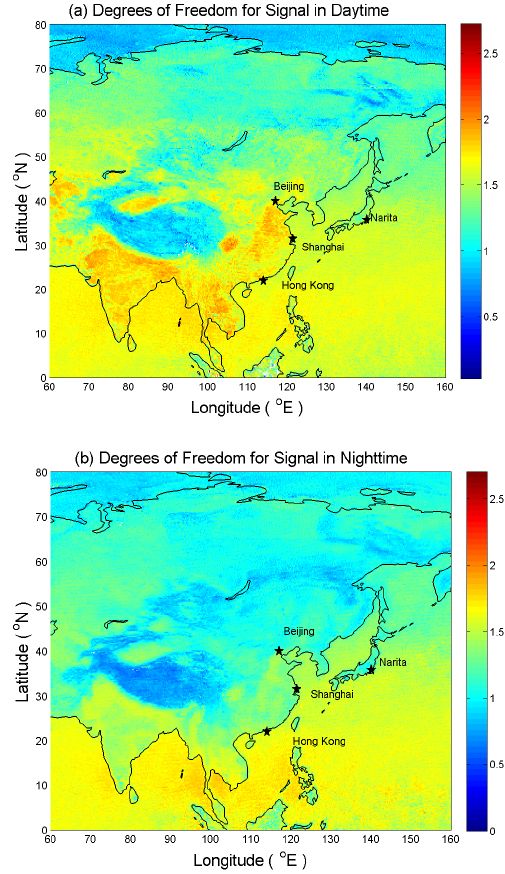
Figure 1. The degree of freedom for signal (DFS) of the MOPITT V5 TIR/NIR data over East Asia, averaged for 2005 during (a) day- time and (b) nighttime. Locations of four cities with MOZAIC CO measurements are indicated as stars. Note that the MOZAIC CO data from Narita also include a small portion of measurements from its surrounding cities at Osaka and